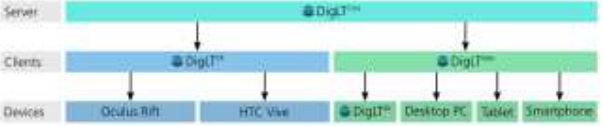
Figure 6: Software components of the DigLT system and possible display devices.